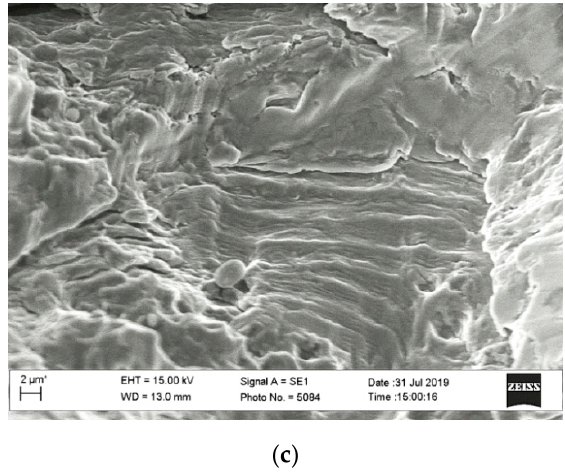
Figure 15. Fractograms in the center of the specimen thickness of the fracture surface: ( a ) Within the starting fracture zones; ( b – c ) within the zones of accelerated crack growth of the specimens, K I – K III with load angle a = 45° .